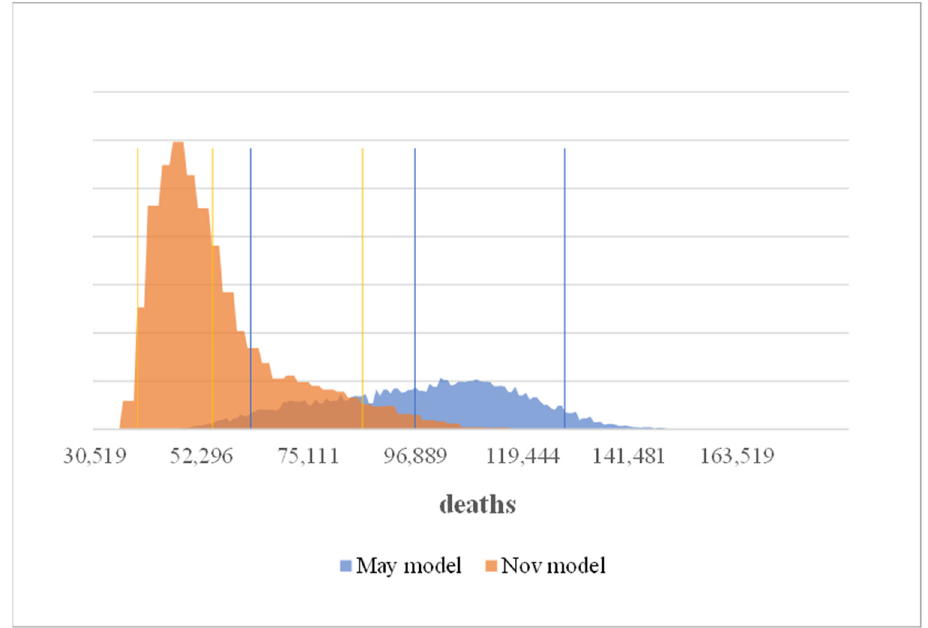
Figure 3. Number of deaths incl. unreported cases at the end of the analyzed period.